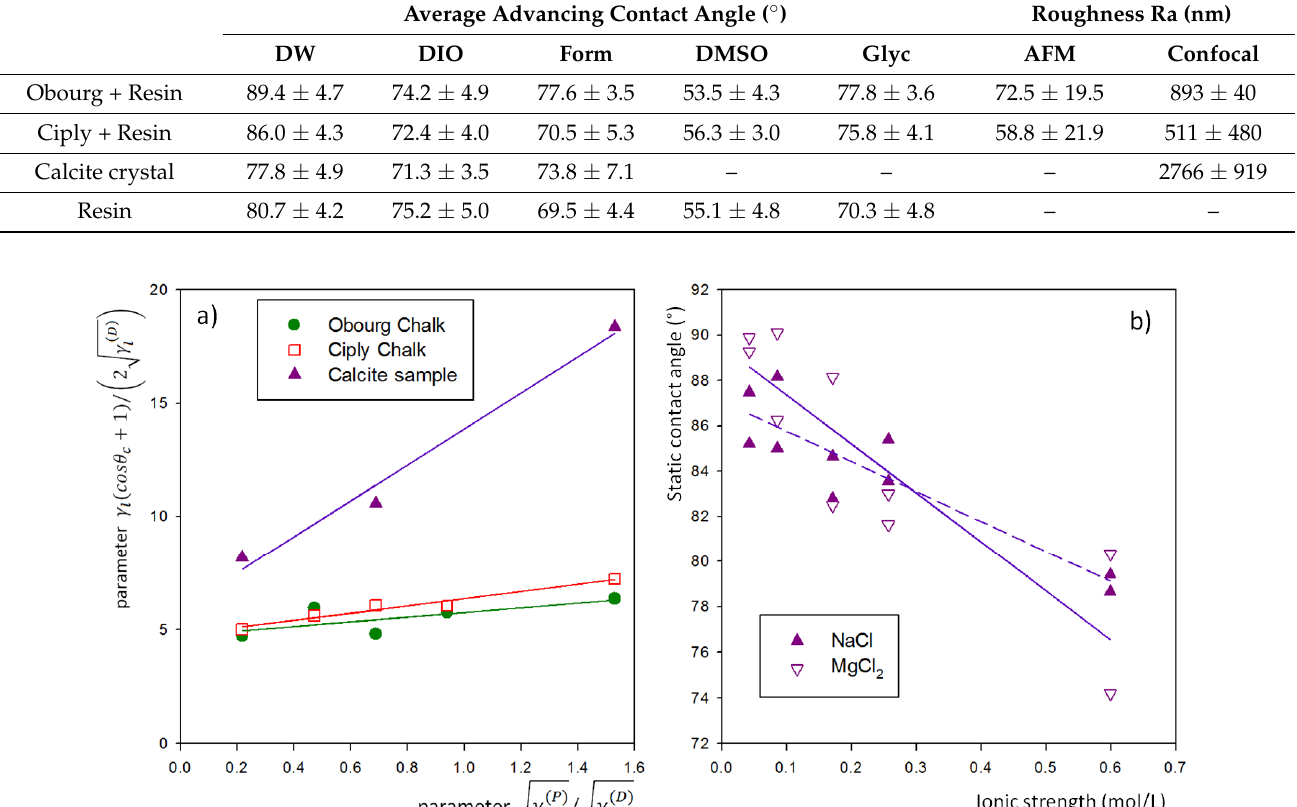
Figure 14. ( a ) Application of the Owens–Wendt method to get the two components of surface energy from the linear regression. ( b ) Contact angle measurements vs. ionic strength for NaCl and MgCl 2 brines in contact with a single calcite crystal.